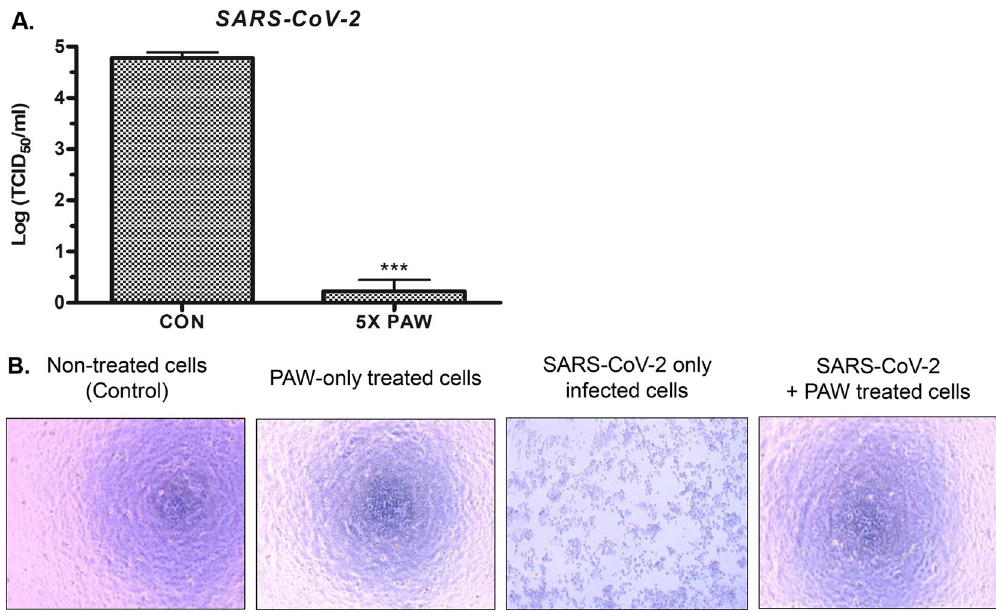
Figure 6. Effectiveness of plasma-activated water (PAW) treatment on SARS-CoV-2 ( A ) SARS-CoV-2 titer treated with concentrated (5 ×) PAW compared to those in PBS-treated samples (control, CON). Each sample was treated for 10 min. ( B ) Bright-field image of SARS-CoV-2 infected Vero-E6 cells showing a viral cytopathic effect (CPE). In the image of SARS-CoV-2 only infected cells, a significant decrease in the number of cells by cytopathic effect of SARS-CoV-2 was observed, compared with the other three images of normal Vero-E6 cells of non-treated, PAW-only treated, and treated with a mixture of SARS-CoV-2 and PAW groups. Each value represents the average ± standard deviation of three replicate measurements. Three replicate measurements were used for statistical analyses. ***P <